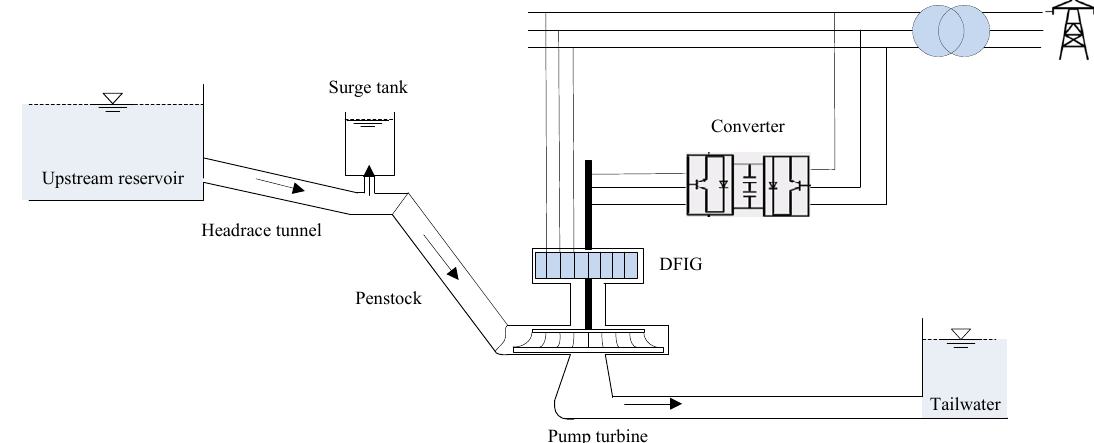
Figure 1. Schematic diagram of a DFVSPSPS.